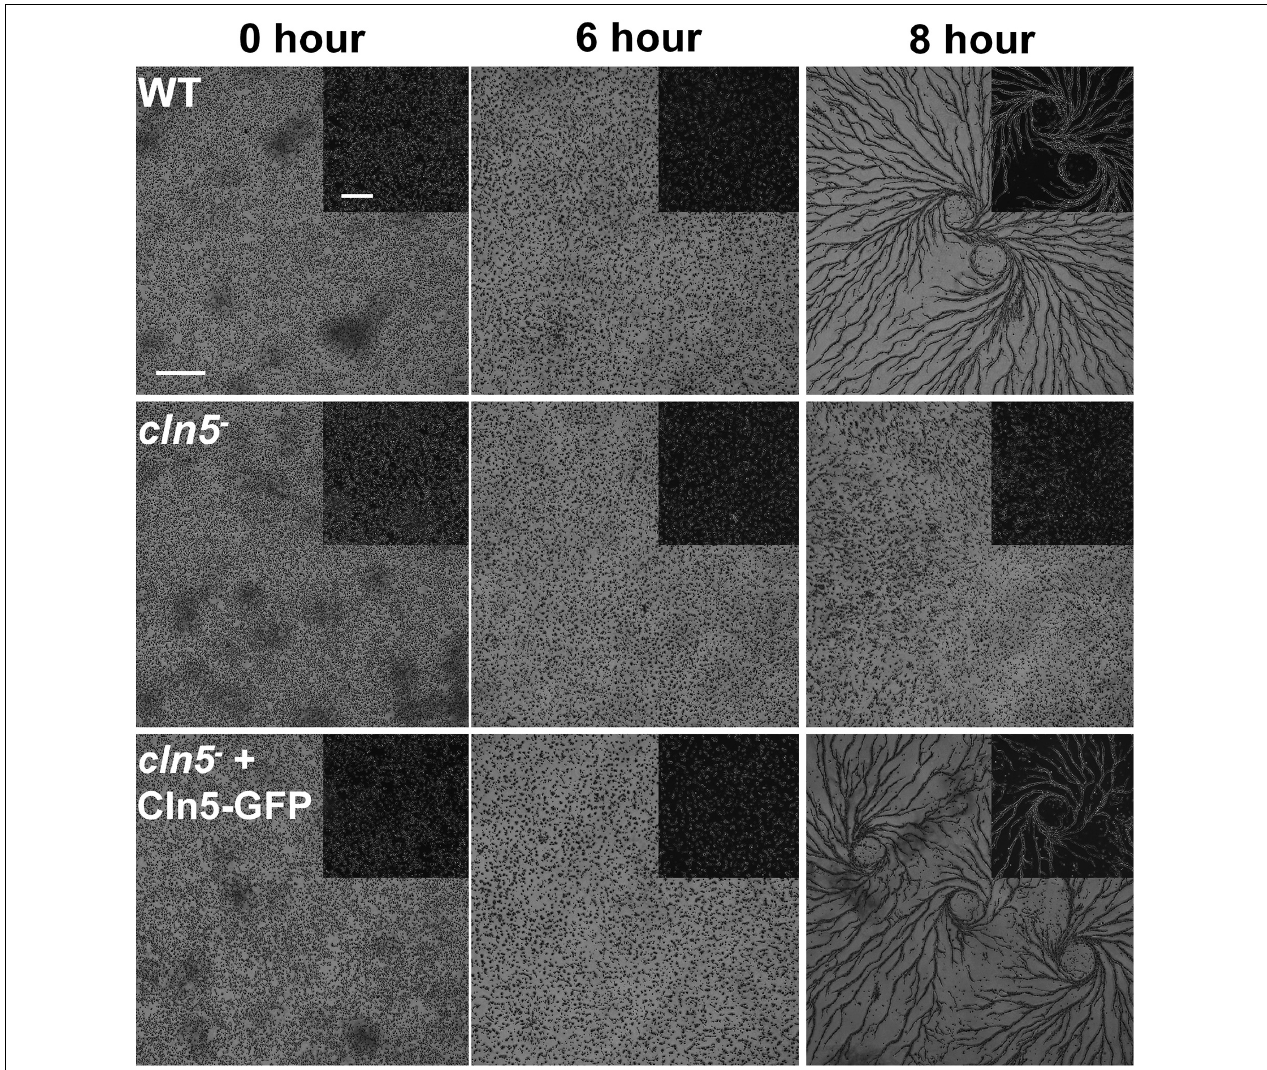
FIGURE 6 | Effect of cln5 -deficiency on aggregation. WT, cln5 − , and cln5 − + Cln5-GFP cells were submerged in KK2 buffer and imaged at the indicated times. Scale bar = 500 µ m. Insert scale bar = 250 µ